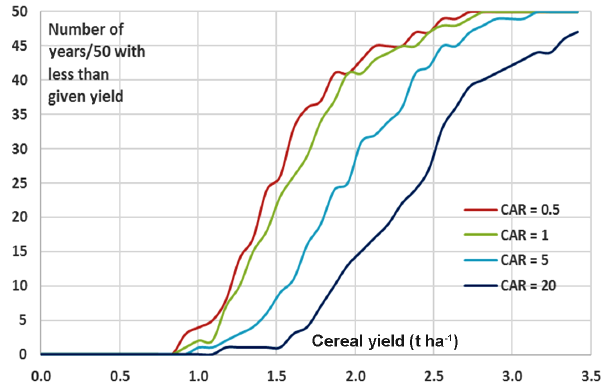
Figure 10. The modelled frequency distribution of crop yields for Mekelle, northern Ethiopia, for a range of ratios of collecting: crop- ping area (CAR), illustrating the greater reliability of crop yields with effective water